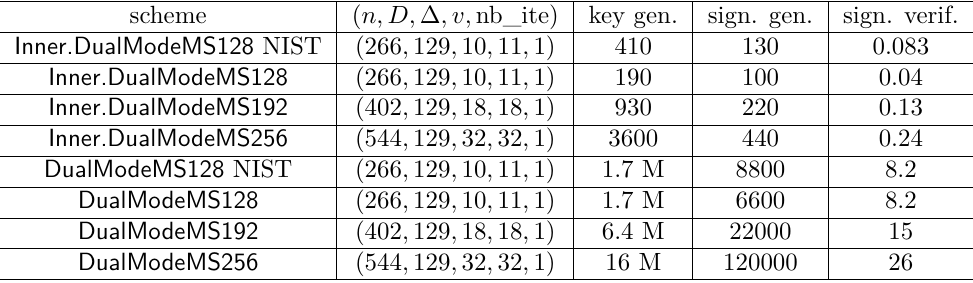
Table 23: Number of mega cycles for each cryptographic operation for DualModeMS . We use a Haswell processor (DesktopH). scheme ( n, D, ∆ , v, nb_ite) key gen. sign. gen. sign. verif.